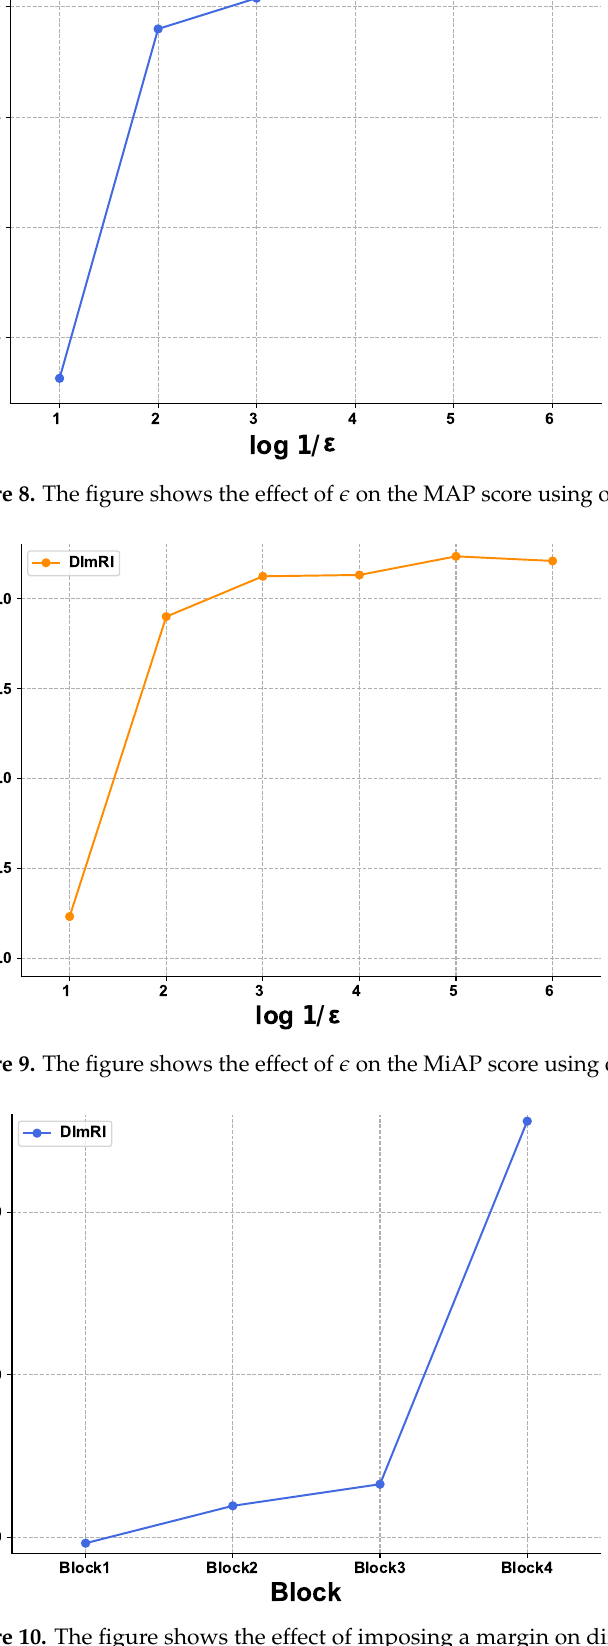
Figure 10. The figure shows the effect of imposing a margin on different blocks on the MAP score using our